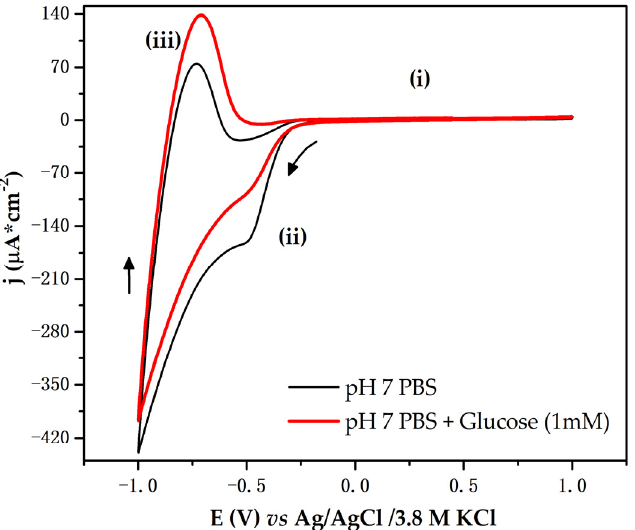
Figure 4. CV curves registered for the Ti/TiO 2 electrode recorded at 10 mV/s in pH 7 PBS and pH 7 PBS with D(+)-glucose at 1 mM. The CV electrochemical response is characterized by region (i) where Faradaic processes do not occur. Regions (ii) and (iii) represent the reduction and oxidation process of TiO 2 , respectively. Arrows depict the sense of potential sweep.